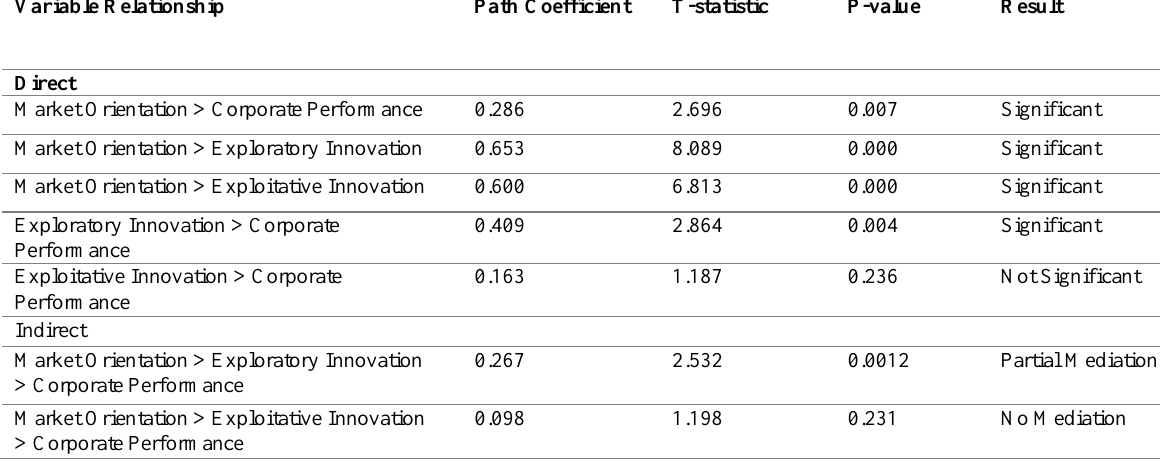
Table 3: Variable Relationship